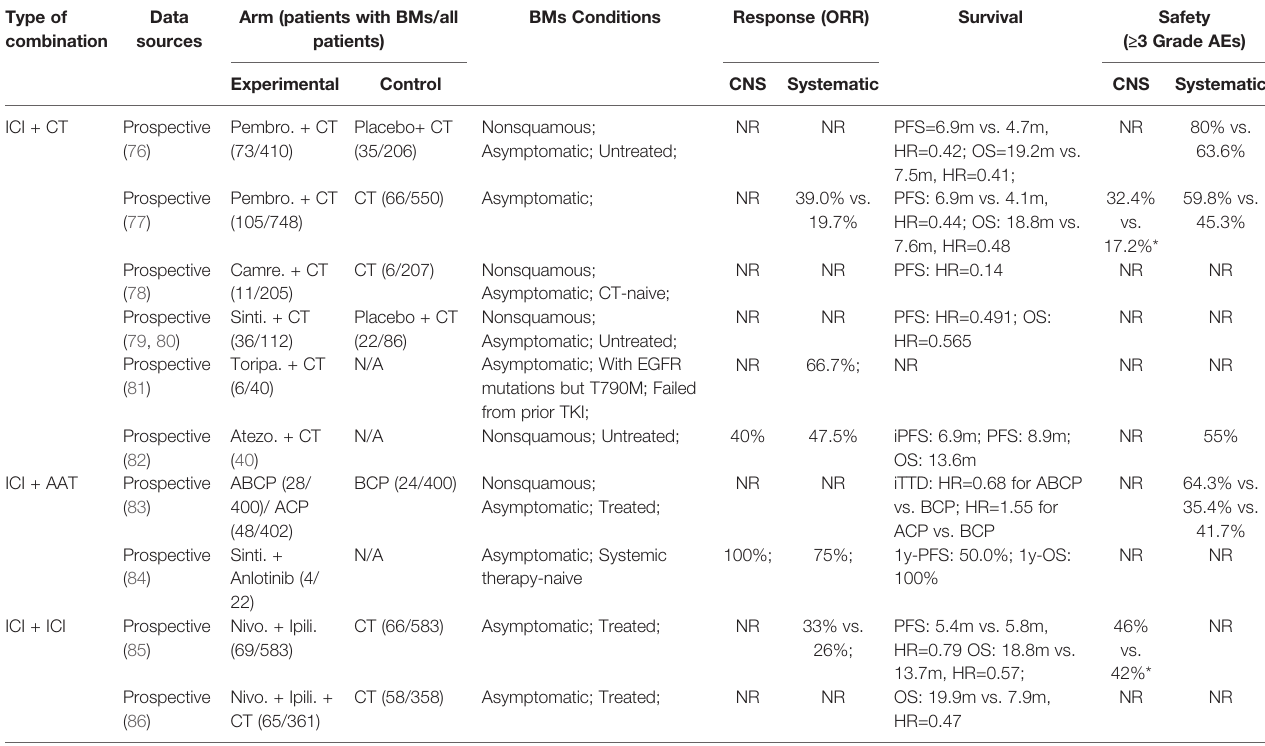
TABLE 3 | Clinical investigations of ICI and other systematic therapies combination in the treatment of NSCLC patients with